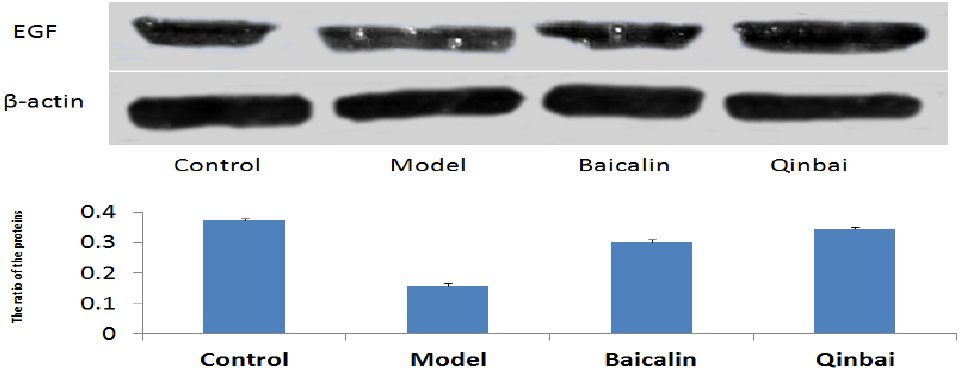
Figure 6. Baicalin and Qinbai had a significant effect on EGF protein expression. Protein extracted from BALB/c mice treated with Baicalin or Qinbai was analyzed by Western blot with an antibody against EGF. Experiments were repeated twice. Data are presented as mean ± SD, p <